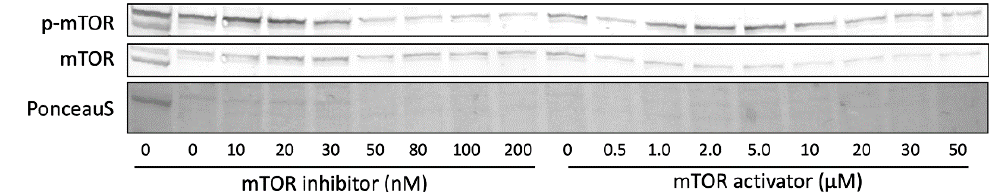
Figure 8. Effects of mTOR inhibition and activation on mTOR phosphorylation. HepG2 cells were treated with 0–200 nM of mTOR inhibitor Torin2 or 0–50 µM of mTOR activator MHY1485 for 48 h.